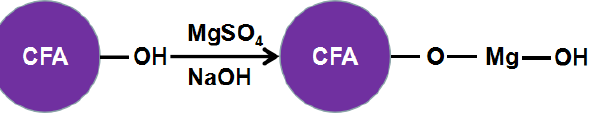
Figure 8. Preparation mechanism of CFAMH composites.